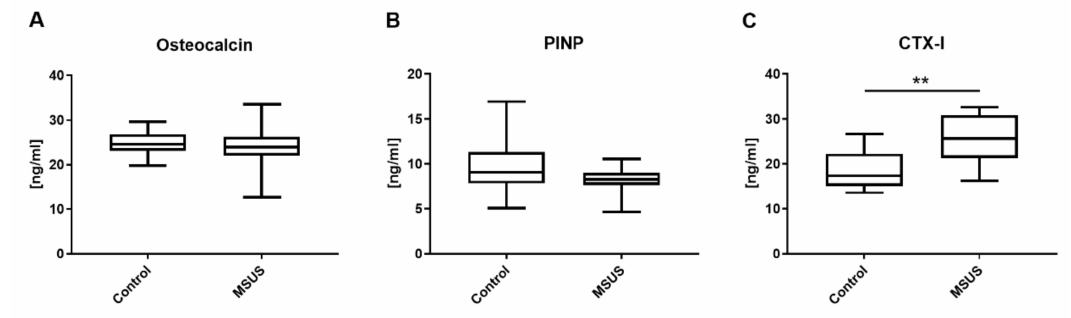
Figure 4. Bone formation and resorption markers in serum of mice. Shown are serum concentration measurements of osteocalcin ( A ), procollagen type 1 N-terminal propeptide (PINP) ( B ) and c-terminal telopeptide of type I collagen (CTX-I) ( C ) in mice. Data ( n = 14 per group) are expressed as Min to Max of concentration in serum [ng / mL]. Significance level: ** p < 0.01 between indicated